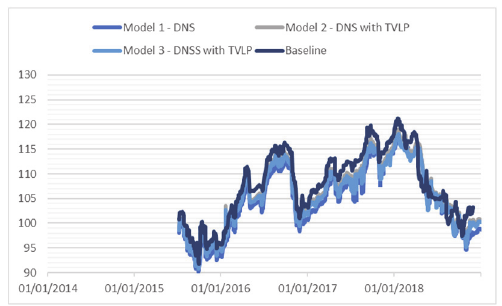
Fig. 4 . Fair price result comparison for FR0059 Fig. 5 . Fair price result comparison for FR0064